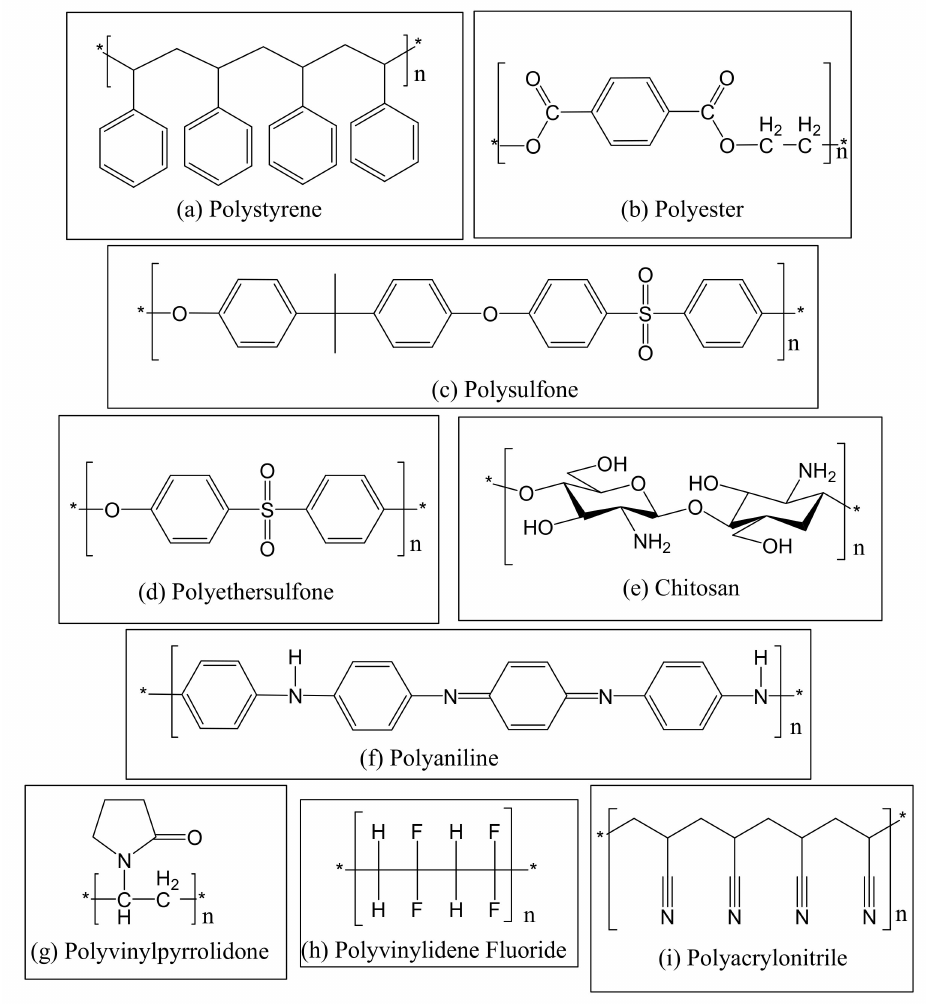
Figure 1. Chemical structures of different types of polymers that are often used in the fabrication of nanofiber membranes. The asterisk (*) indicates that the structure is